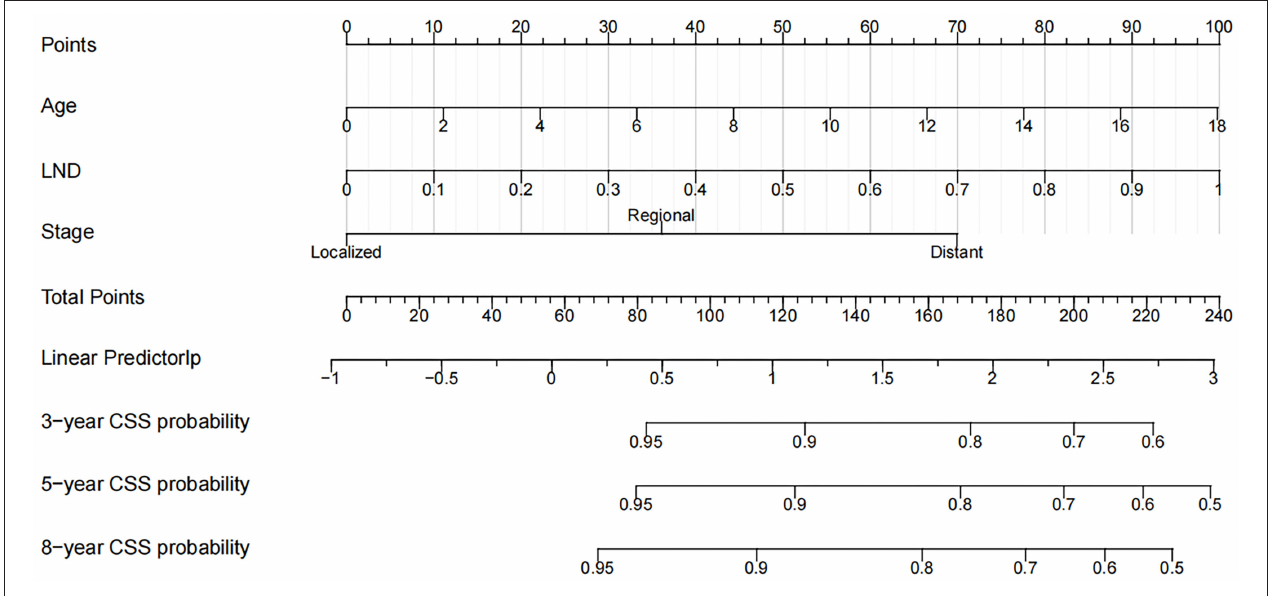
FIGURE 2 | Nomogram for 3-, 5-, and 8-year CSS of children with WT.